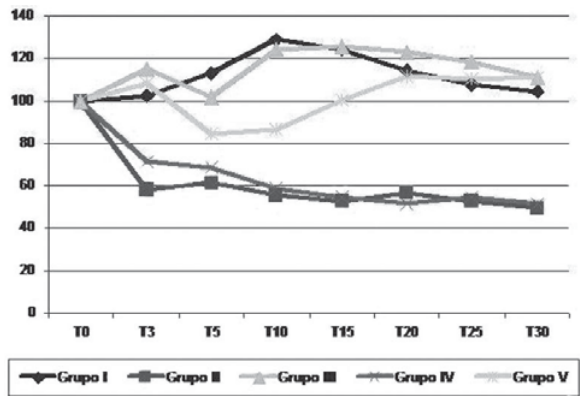
Fig.5 - Variação percentual da contratilidade miocárdica (dP/dT) em milímetros de mercúrio por segundo, dentro dos períodos estudados em cada